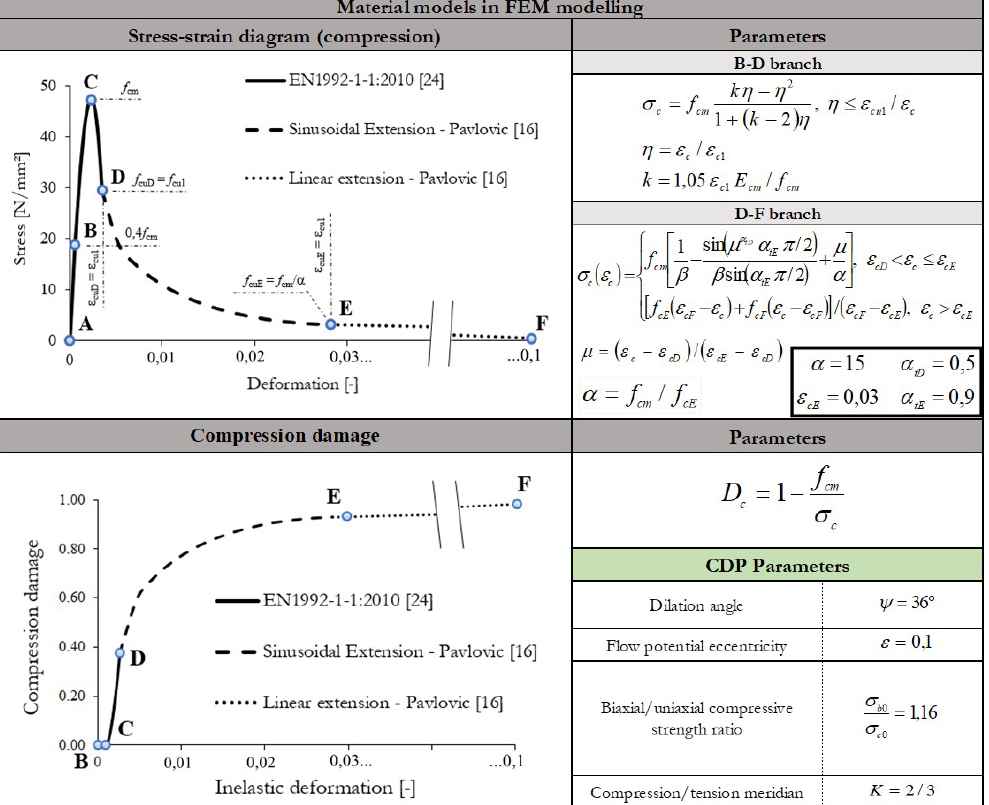
Figure 10. Material model for compression and CDP model